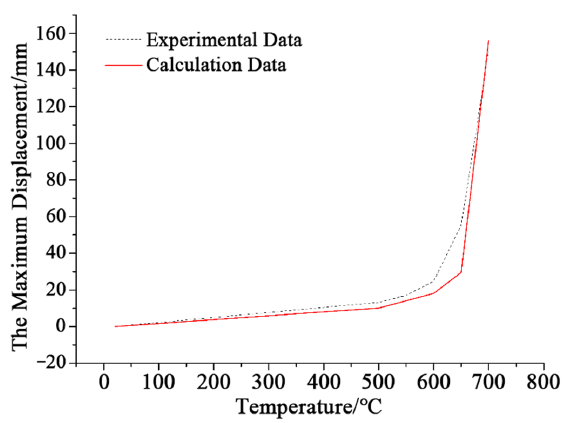
Figure 17. Displacement–temperature curve .